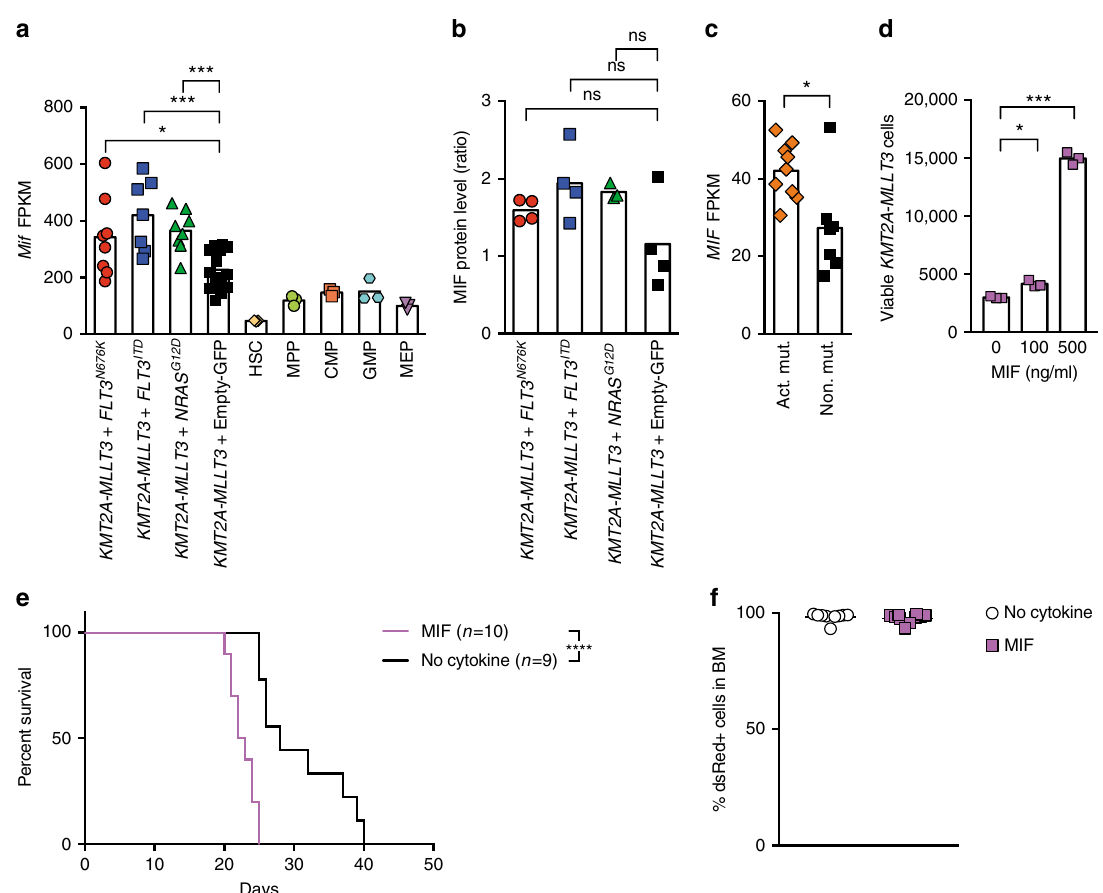
Fig. 5 MIF promotes survival of KMT2A-MLLT3 leukemia cells. a Mif expression (FPKM) in mouse KMT2A-MLLT3 leukemias with or without FLT3 ITD , FLT3 N676K , or NRAS G12D , as well as in sorted normal mouse hematopoietic progenitors 36 of hematopoietic stem cells (HSC), multipotent progenitors (MPP), megakaryocyte erythroid progenitor (MEP), common myeloid progenitor (CMP), and granulocyte macrophage progenitors (GMP) (Supplementary Table 4). b Relative MIF protein abundance in mouse KMT2A-MLLT3 leukemic cells with or without FLT3 ITD , FLT3 N676K , or NRAS G12D as determined by quantitative mass spectrometry. c MIF expression in infant KMT2A-AFF1 ALL patients with activating mutations (dominant or subclonal) to those lacking such mutations 4 . d Number of viable KMT2A-MLLT3 leukemia cells when cultured with increasing concentrations of MIF after 6 days of ex vivo culture without IL3 ( n = 3). e Kaplan – Meier survival curve for recipient mice transplanted with serially propagated dsRed + KMT2A-MLLT3 cells 44 cultured ex vivo for 3 days with or without 500 ng/ml MIF. f Flow cytometric analysis on bone marrow (BM) from moribund mice revealed a majority of leukemia (dsRed +